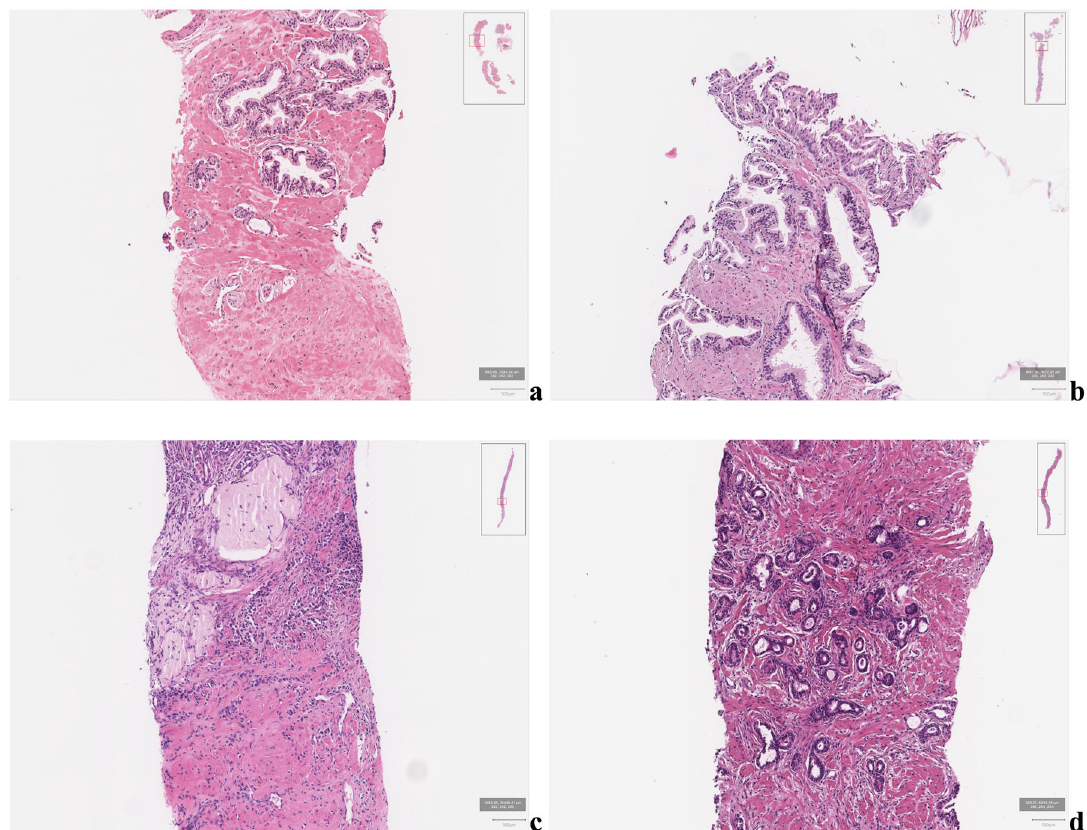
Fig. 2 Sample patch images from failure cases (Hematoxylin-eosin stain, ×200). False-negative cases showed small-sized cancers, which consisted of only several cancer glands, or cancer glands located on the outer sample margin of the WSI. a was diagnosed as grade group 1 and b as grade group 4 in the reference standard, respectively. False-positive cases often exhibited diffuse in fi ltration of lymphocytes and atrophic glands. The prediction of the model was grade group 4 for ( c ) and grade group 1 ( d ),